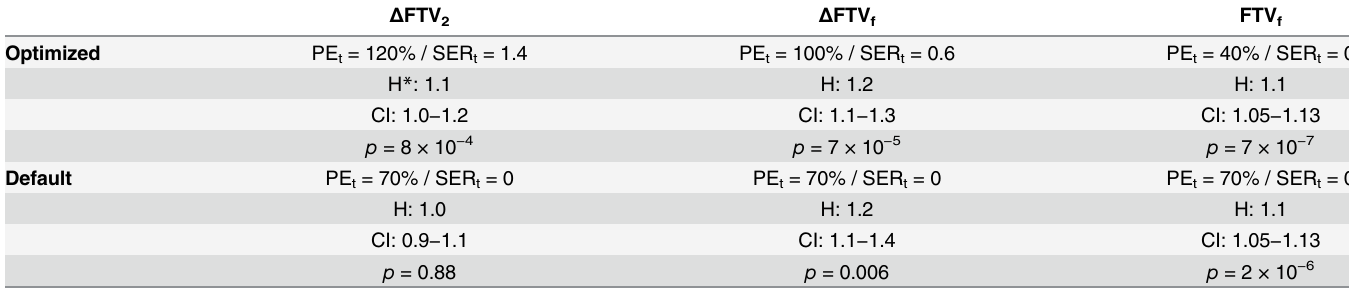
Table 2. Cox proportional hazards ratios at PE t /SER t with optimized association with RFS and at the default setting for the full cohort. Δ FTV Δ FTV 2 f FTV f Optimized PE t = 120% / SER t = 1.4 PE t = 100% / SER t =